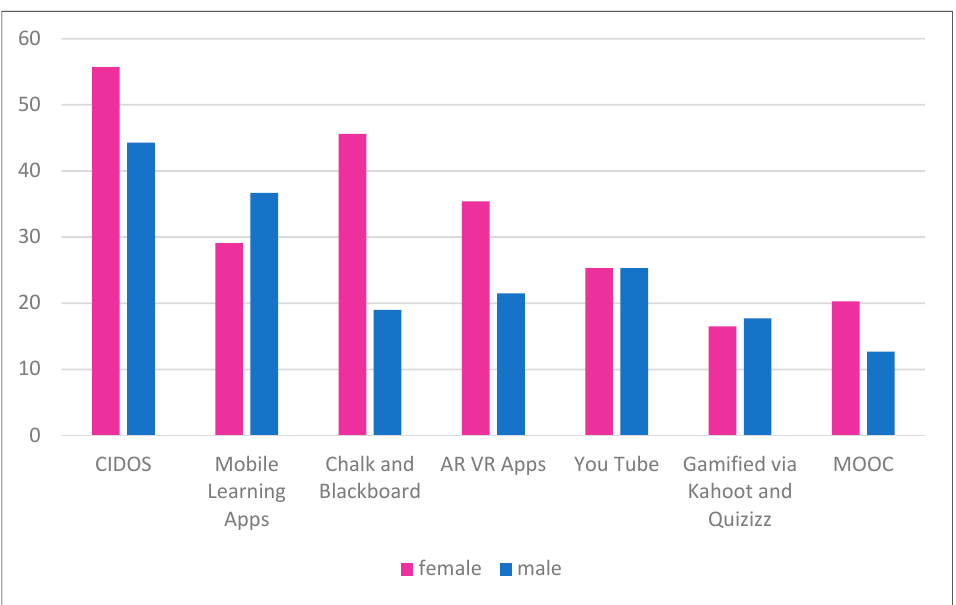
Figure 5. Students’ demand for the use of digital learning platforms and tools by gender .